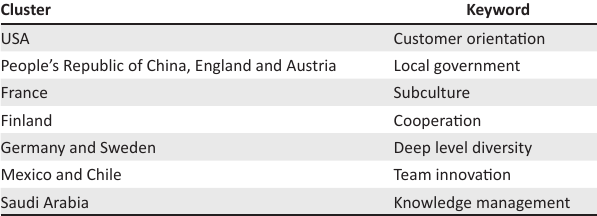
TABLE 3: The top 10 journals for organisational culture